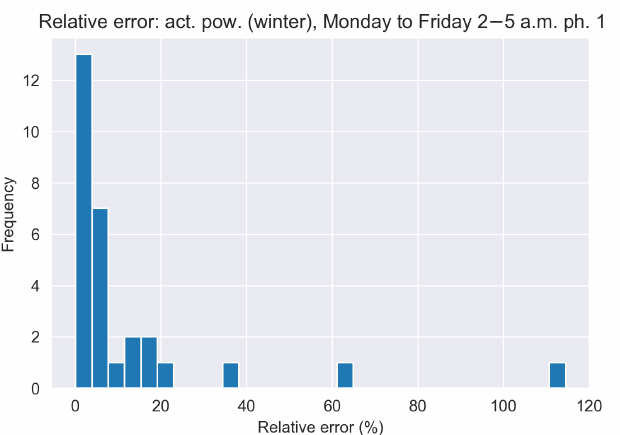
Figure 7. Histogram of relative error R i calculated from matrix analytic calculation based on MMP-GapT model for active power winter morning traces shown in Figure 6.